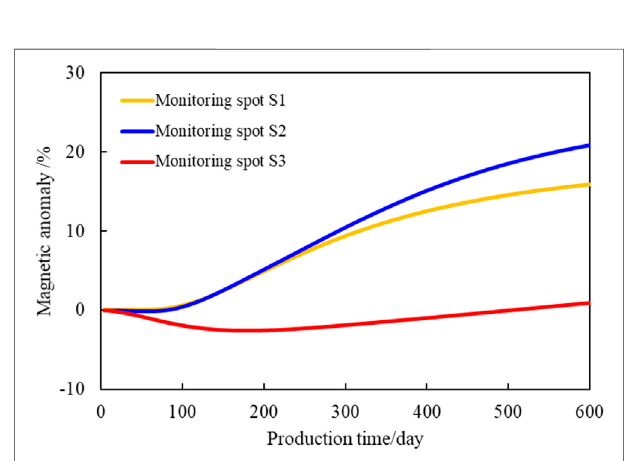
FIGURE 11 | Magnetic anomaly curves of monitoring spots located in different